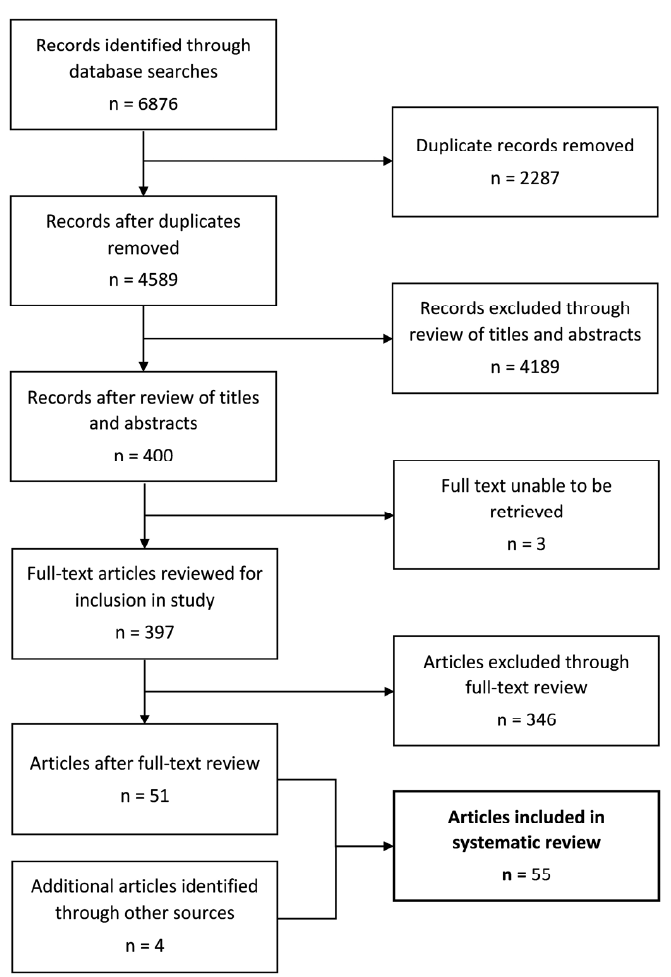
Figure 2. Flow diagram for the review